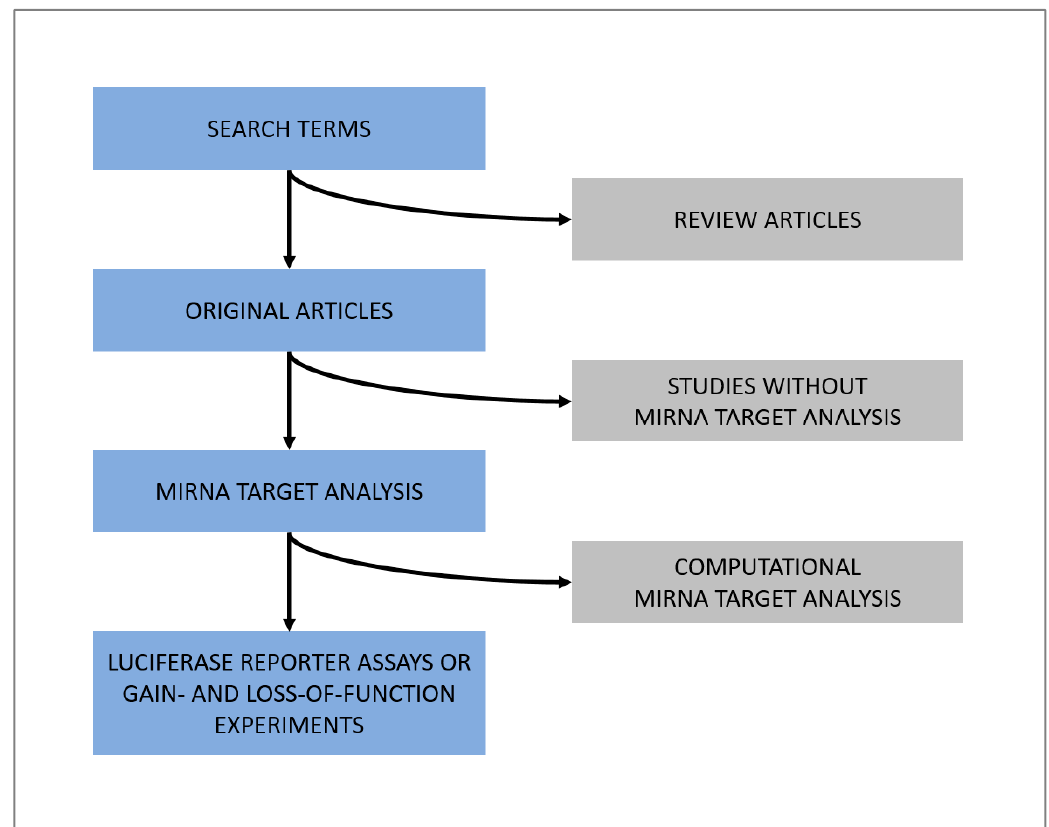
Figure 8. Diagram of literature search rules applied for all miRNAs with a low mean CTcorr value ( ≤ 29.99) in both CB- and AT-MSC-derived EVs. Search terms were “name of miRNA”, “name of miRNA” AND “heart”, “name of miRNA” AND “cancer”, “name of miRNA” AND “fibrosis”, “name of miRNA” AND “endothelial cells”, “name of miRNA” AND “angiogenesis”, “name of miRNA” AND “immunomodulation”, “name of miRNA” AND “macrophages”, “name of miRNA” AND “t-cells”, and “name of miRNA” AND “immune cells”.